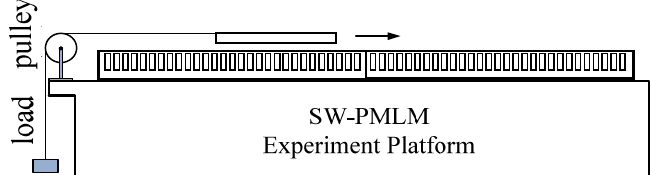
Figure 15. Load diagram of WS-PMLM.